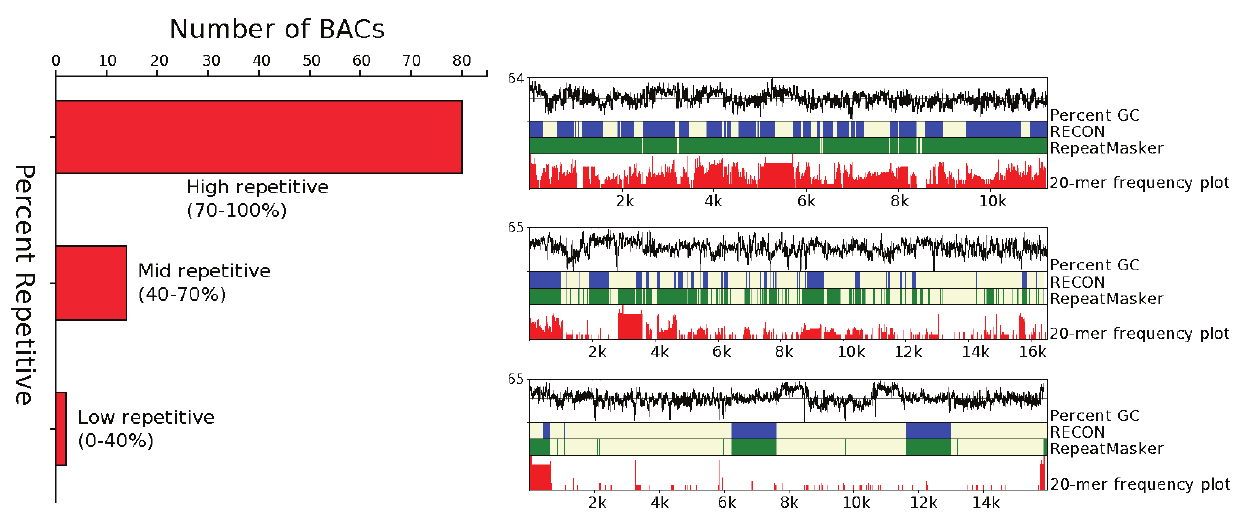
Figure 1. Percent of total BAC clones classified as low, mid and high repetitive based on the frequencies of the overlapping 20-mers for each clone. The right hand side panel is an illustration of each type of BAC clone (low, mid and high repetitive) with tracks showing the percent GC, RECON [46] and RepeatMasker [48] annotations along with the frequency of 20-mers [53] for each clone is shown. The repeat-rich and repeat-poor regions, as shown by the 20-mer frequency plot by Tallymer and supported by the RECON and RepeatMasker annotations can be differentiated